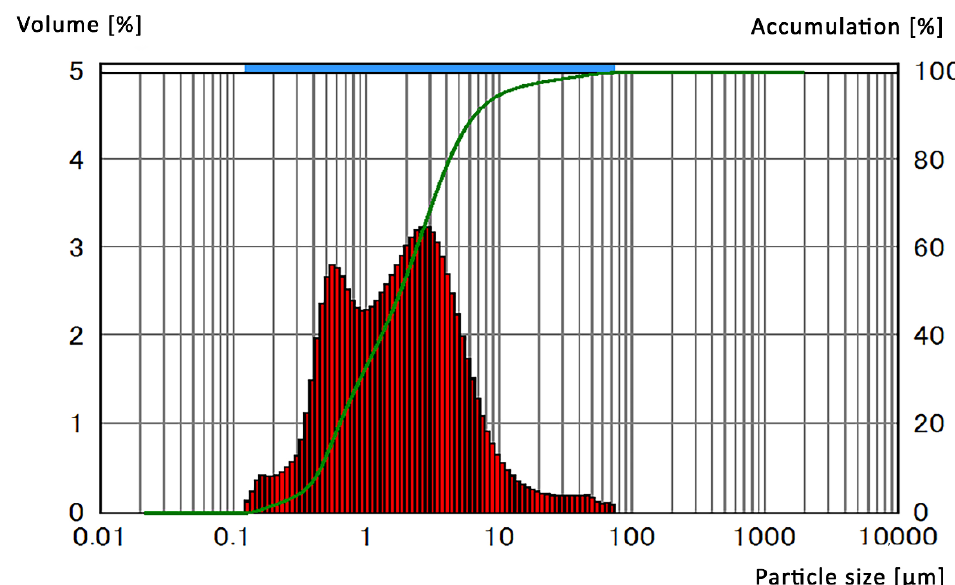
Figure 2. Powder size distribution of NbC measured by DLS method.